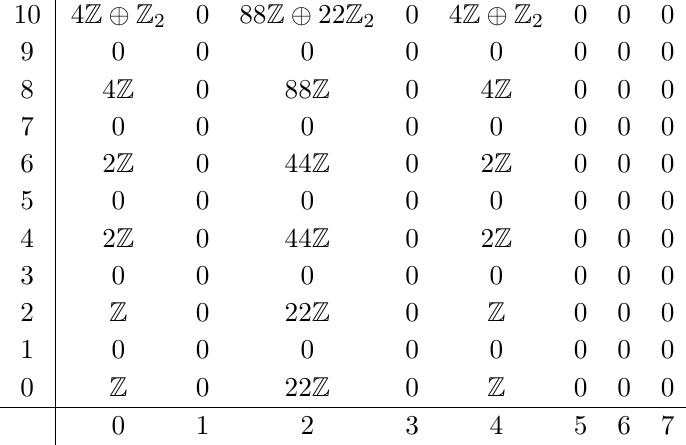
Table 11 . Second (and final) page of the AHSS for the computation of Ω Spin c